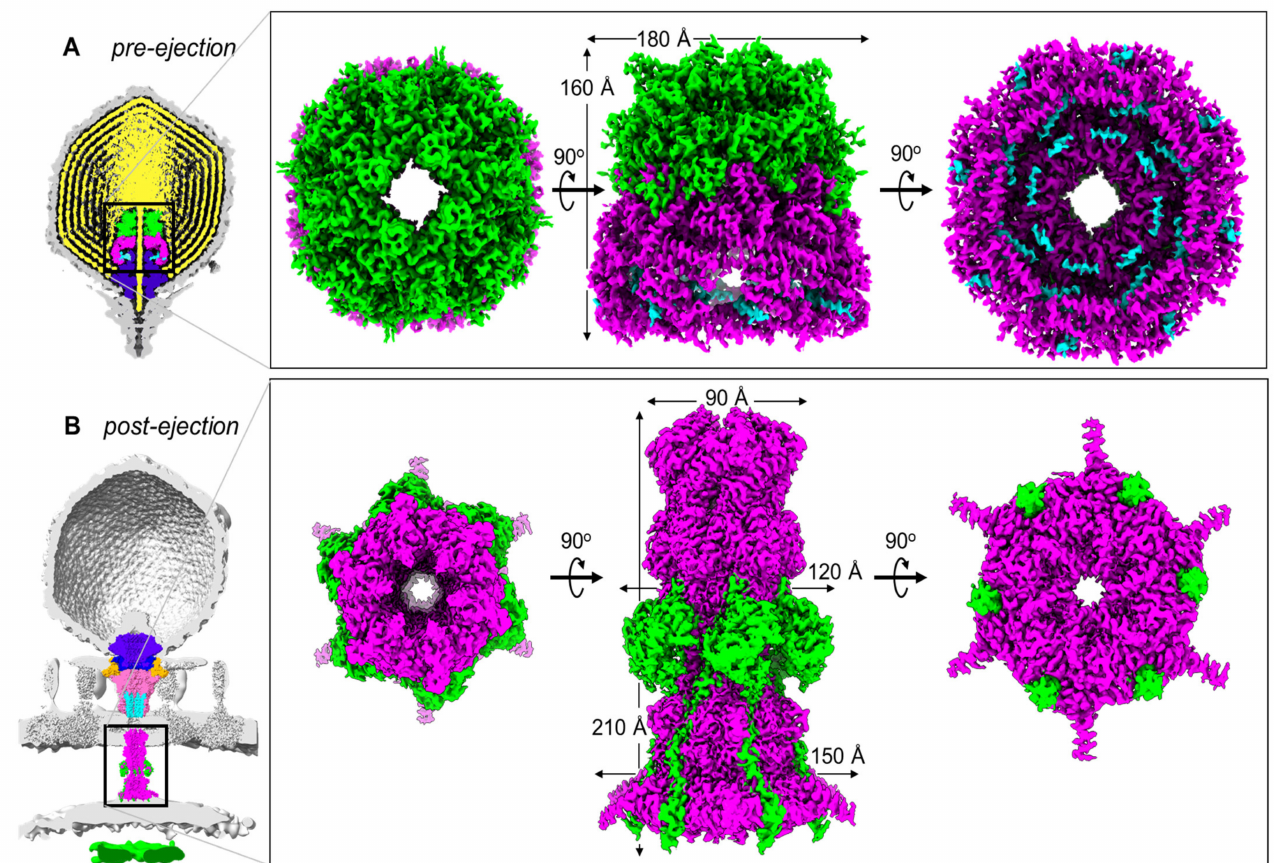
Figure 1. T7 ejection proteins cryo-EM maps. ( A ) Slice through the cryo-EM reconstruction of the T7 mature virion (map EMD-31315) revealing the pre-ejection conformation of gp14 (cyan), gp15 (magenta), and gp16 (lime green) assembled into a core stack (PDB id 7EYB) on the portal protein (purple) and surrounded by the viral genome (yellow). ( B ) Slice through the cryo-EM reconstruction of LPS-treated empty T7 phage (map EMD-31318) superimposed onto the cryo-ET reconstruction of T7 infecting E. coli minicells (map EMD-5534). The structure of T7 gp15:gp16-N (PDB id 7K5C) was overlaid with the cryo-ET density. Other proteins: portal (purple; PDB id 7EY6), tail complex (gp17 tail fibers in orange, gp11 adaptor in dark blue, gp12 nozzle in hot pink; PDB id 7EY7), gp14 (cyan; PDB id 7EY7). The zoom-in panel shows the structure of the gp15:gp16-N complex assembled to form a periplasmic